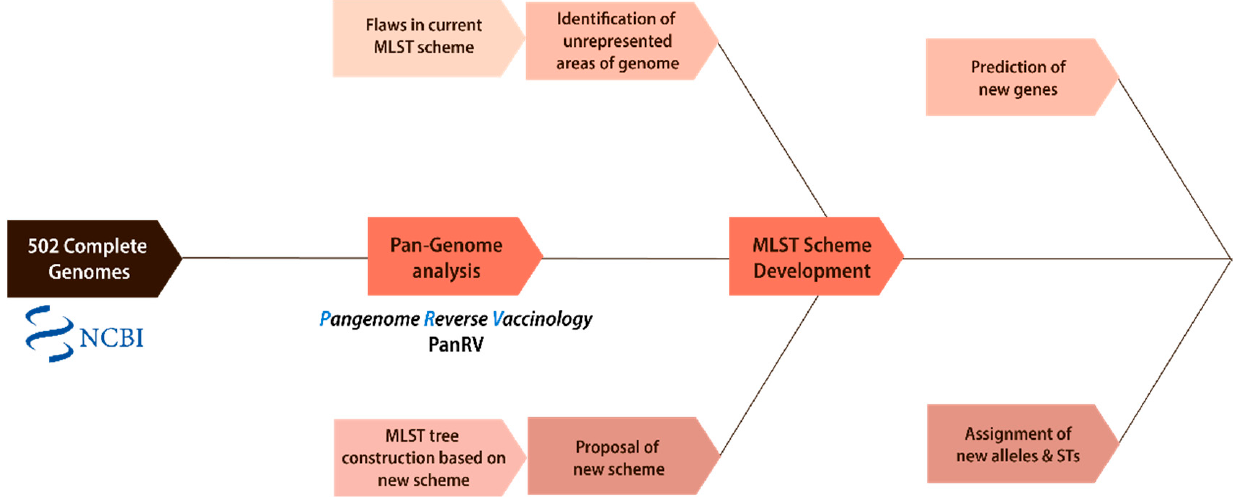
Figure 1. Overall methodology. The flowchart demonstrates the overall methodology followed in this study. It shows the two main components: phylogenetic analysis and the development of a new MLST